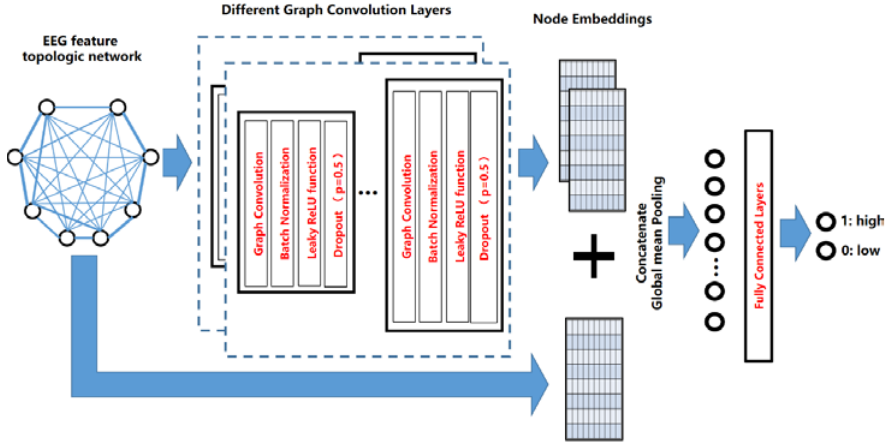
Fig. 3. The structure of EEG-GCN: Graph convolutional neural network based on topological graph of EEG features.